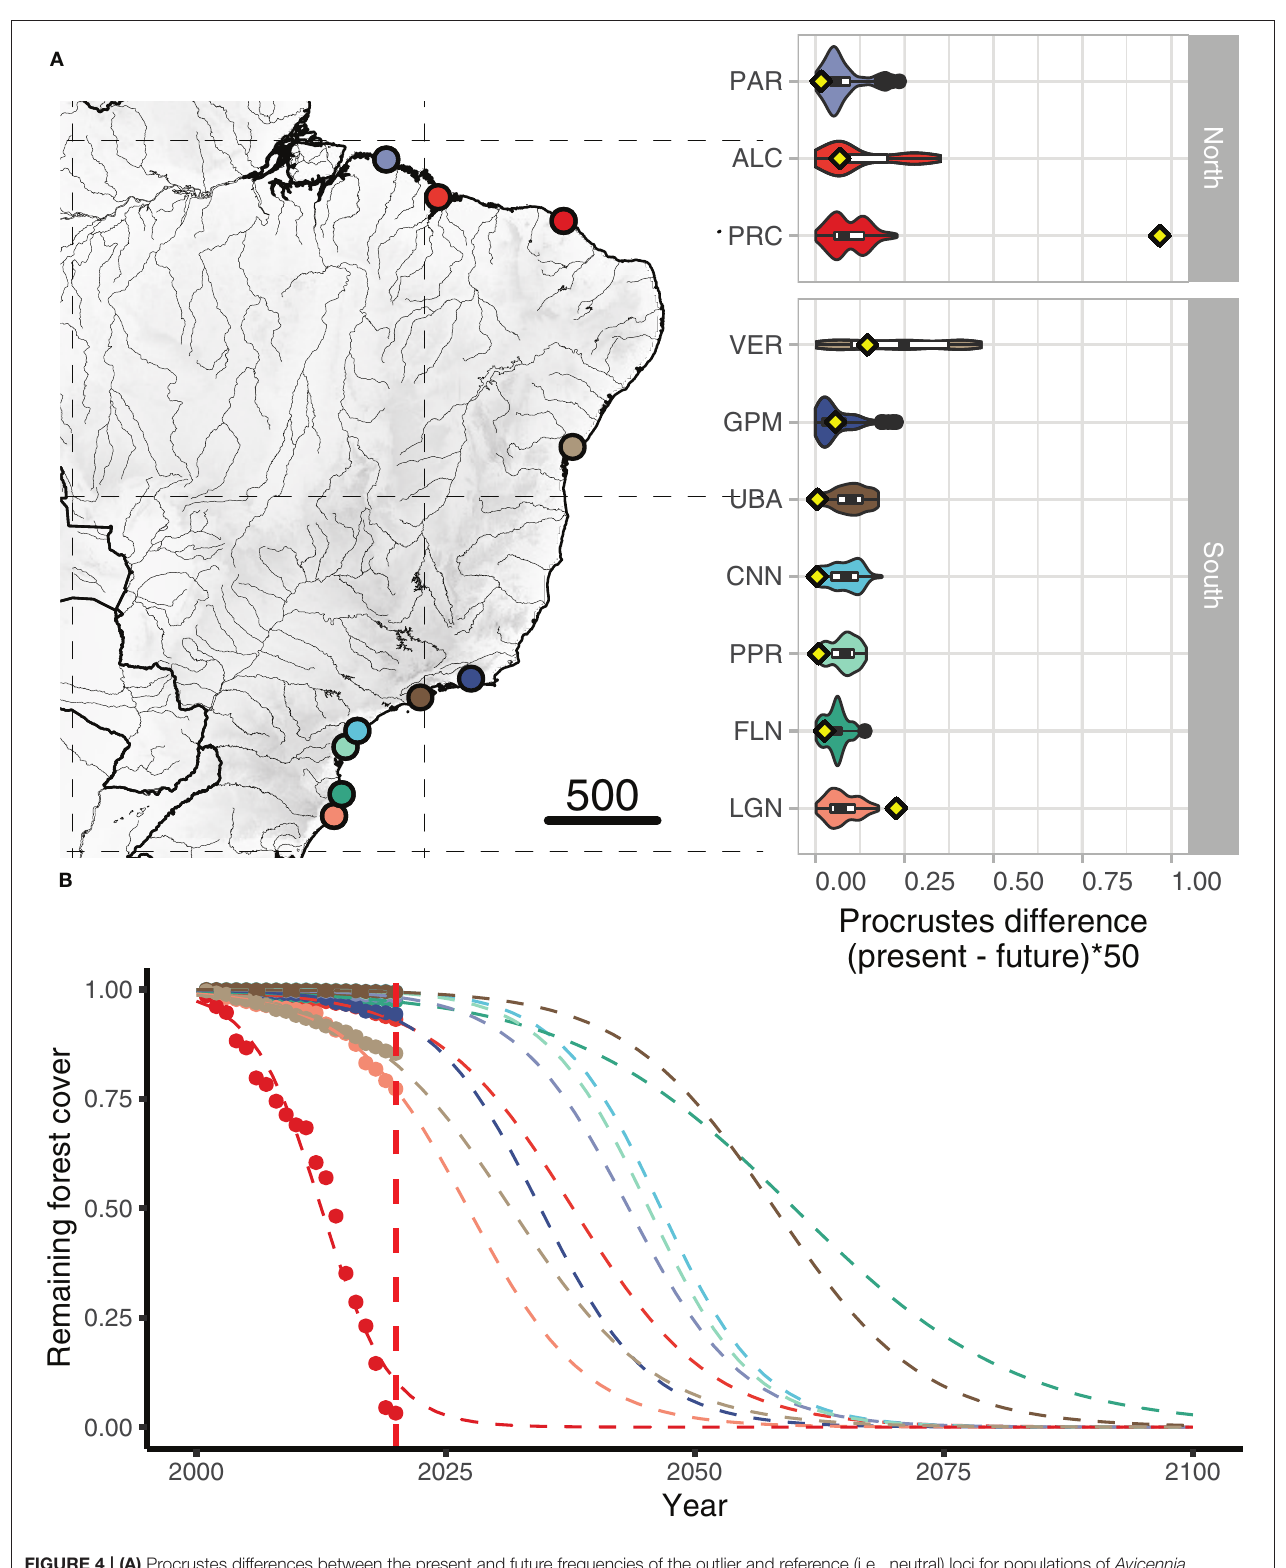
FIGURE 4 | (A) Procrustes differences between the present and future frequencies of the outlier and reference (i.e., neutral) loci for populations of Avicennia schaueriana obtained with gradient forest RDA/PCAdapt; the yellow dots represent the proportion of forest cover lost by 2020. (B) Yearly deforestation rates (2000–2020) for each A. schaueriana region included in our